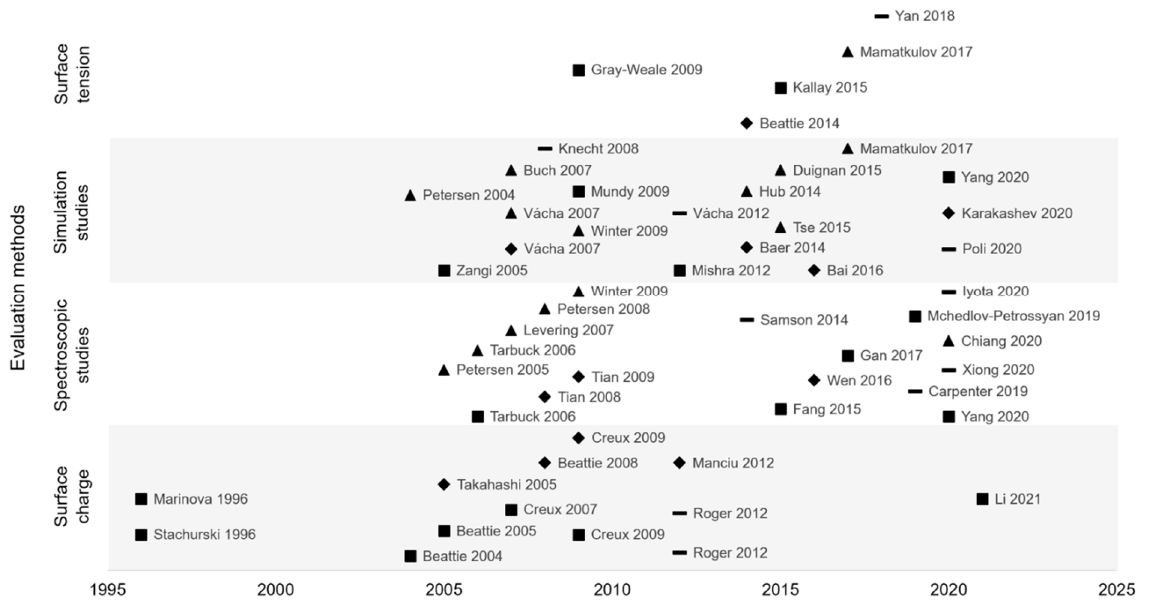
Figure 10. Interfacial organization hypotheses ( ■ hydroxide ions (OH − ) adsorption, ▲ hydronium ions (H 3 O + ) adsorption, ◆ OH − and H 3 O + adsorption, – other hypotheses) according to experimental methods used and publication date of papers.